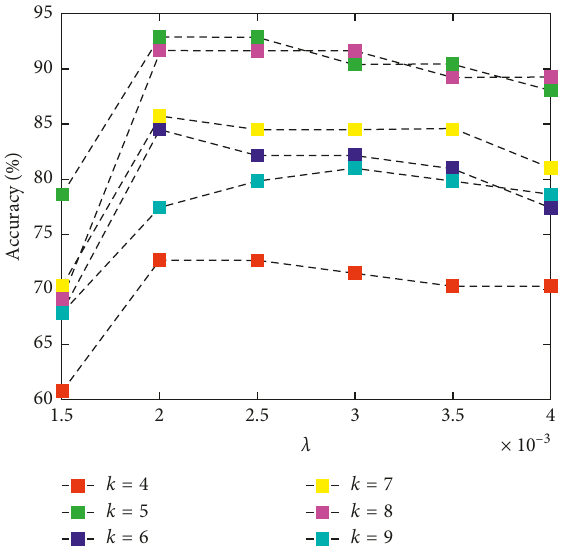
Figure 3: Cross-validation set identification rate.